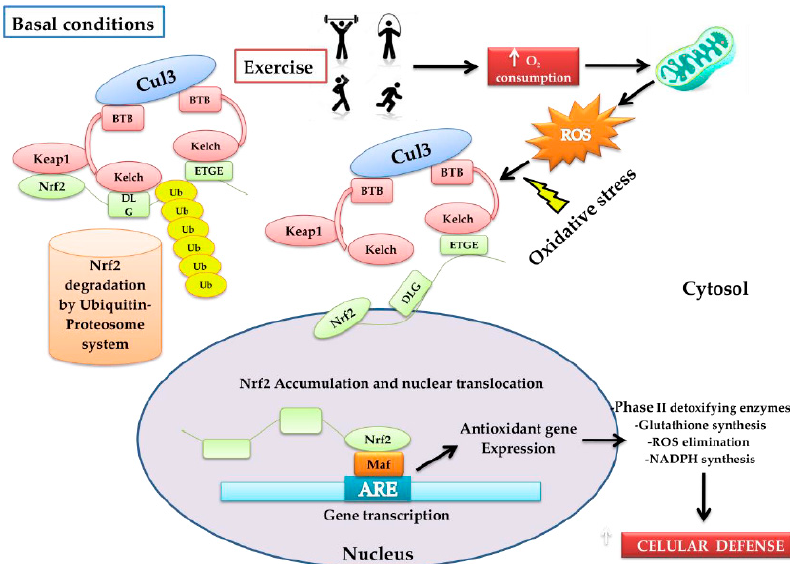
Figure 1. Model that proposes the form in which physical activity activates the nuclear factor erythroid 2-related factor 2 (Nrf2)–Keap1 pathway. Under normal conditions, Nfr2 is found bound to Keap1 through the DLG and EGTE motifs in the Neh2 domain of Nrf2 by the ubiquitin ligase complex Cullin (Cul)3-RING-box protein (Rbx)1 (Cul3). This complex ubiquitinizes Nrf2 for its rapid proteosomal degradation. When physical exercise is carried out, it increases oxygen absorption, transport, and consumption in the entire organism (O 2 consumption). In this process, the reactive oxygen species (ROS)-producer metabolic pathways are stimulated, increasing oxidative stress (OS). The latter induces oxidation of the cysteine residues present in Keap1, favoring the conformational change of Keap1; consequently, ubiquitination is impeded and Nrf2 dissociates itself from the inhibitor complex. Nrf2 accumulates and translocates into the nucleus, and heterodimerizes with musculoaponeurotic fibrosarcoma proteins MAF proteins, bonding in a specific DNA sequence denoted as the antioxidant response element (ARE), inducing the expression of the antioxidant genes: (a) phase-II antioxidant enzymes; (b) glutathione synthesis; (c) ROS elimination, and d) the synthesis of NADPH, among others. In conjunction with these, an increase in cytoprotector cellular defenses occurs.